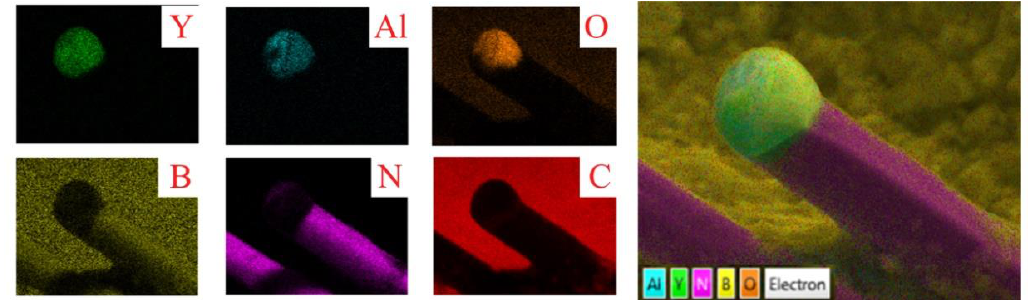
Figure 4. Element scanning maps of a typical BN nanotube under SEM: single element distribution (left), and combination maps (right).